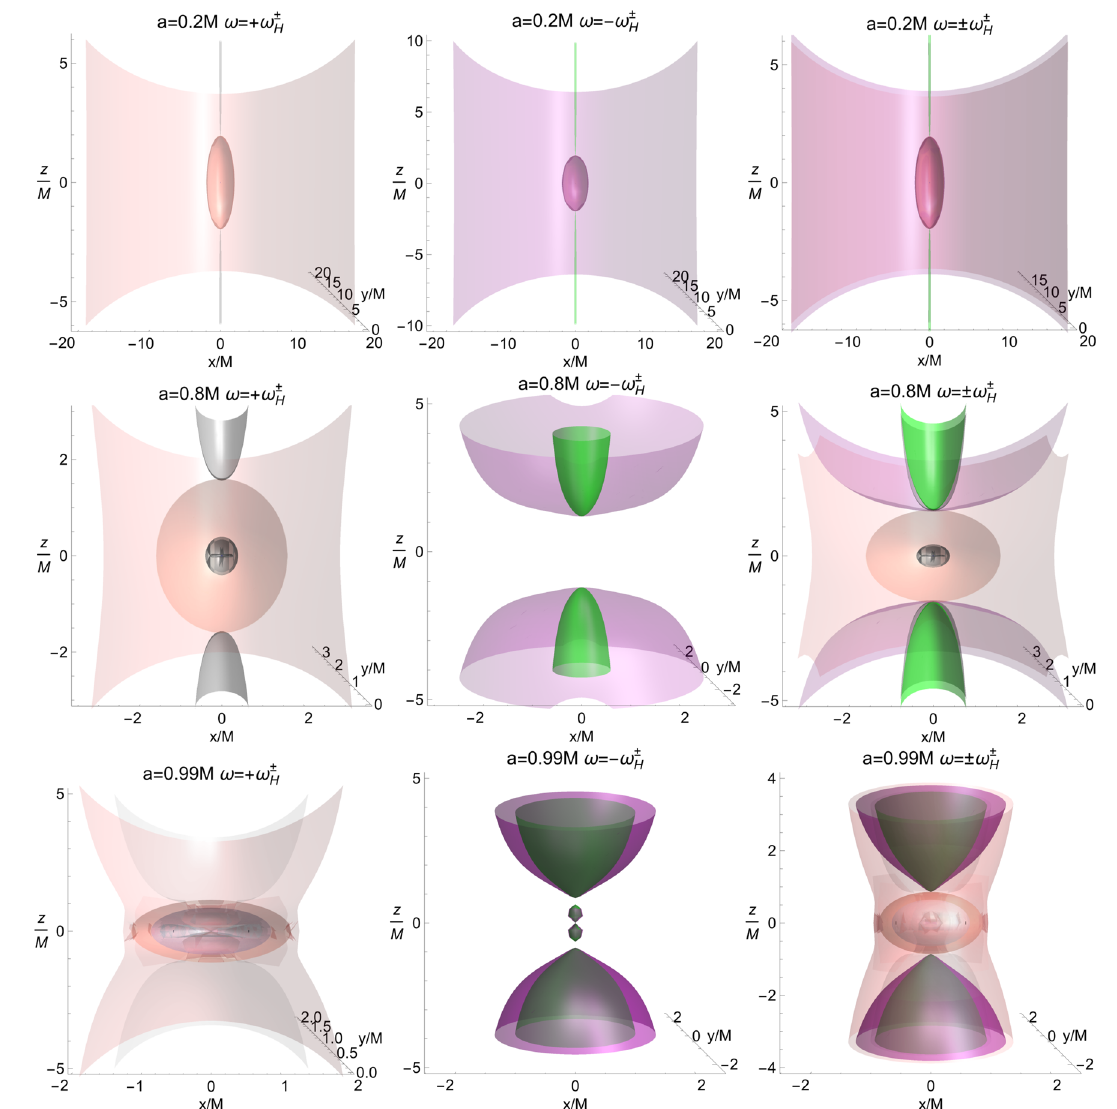
Fig. 2 Replicas in a fixed Kerr BH geometry with dimensionless spin a / M . ω ± aretheouterandinner BH horizonsfrequencies,respectively. H The inner and outer horizons spheres are shown as blue and orange spheres, respectively, and the analysis covers the replicas structure in the region [ r + , +∞[ . The replicas structures in the region ] 0 , r − ] is also included, where r ± are the outer and inner BH horizon. In some panels, the inner and outer horizon spheres can be seen as embedded in repli- cas. In the plots { z = r cos θ, y = r sin θ sin φ, x = r sin θ cos φ } . Co- rotating outer and inner horizon replicas with frequency ω = + ω ± counter-rotating outer and inner horizon replicas ω = − ω ±